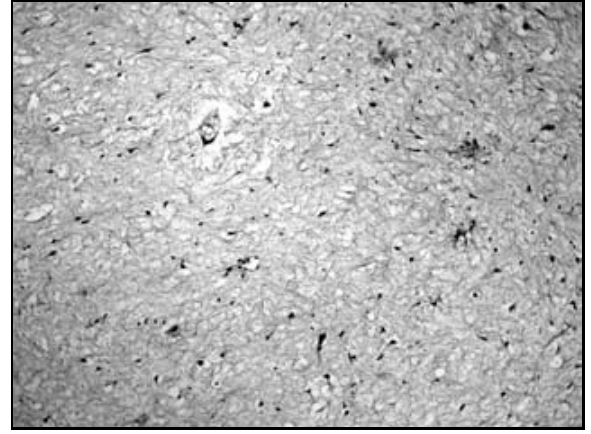
Figura 1 – Tumor hipocelular, com células de núcleos fusiformes em meio a estroma mixóide (HE 200x)